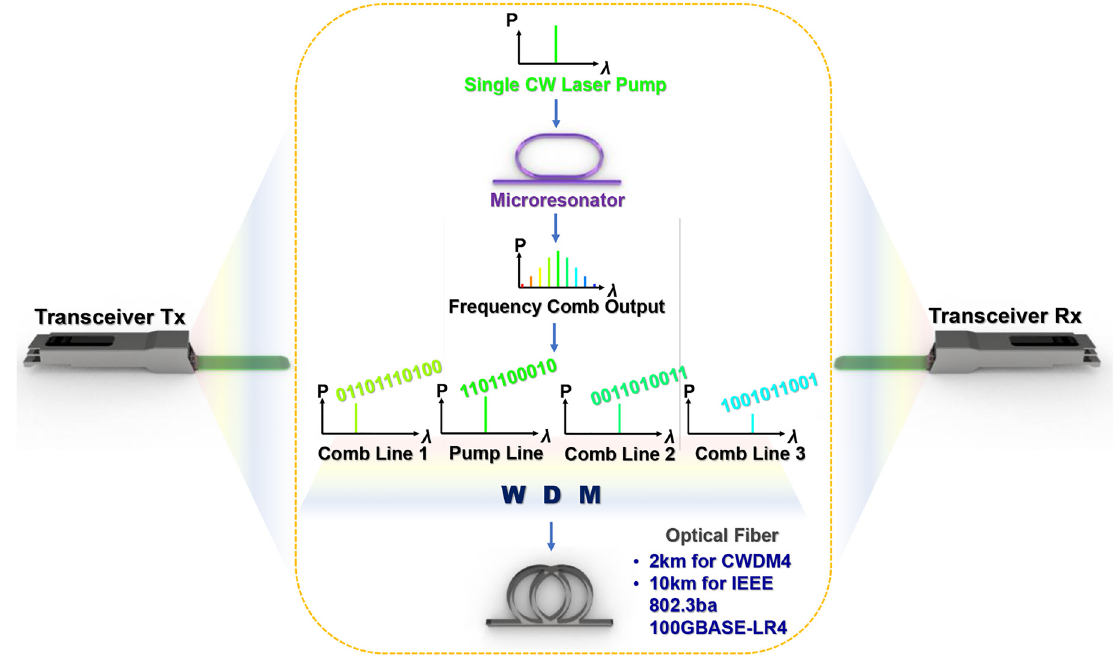
Figure 1: Schematic of transceiver-based data center communications. Tx: transmitter, Rx: receiver, WDM: wavelength division multiplex. The orange dotted line highlights the frequency comb-based multi-wavelength high-speed data transmission over fiber which we demonstrate in this paper.